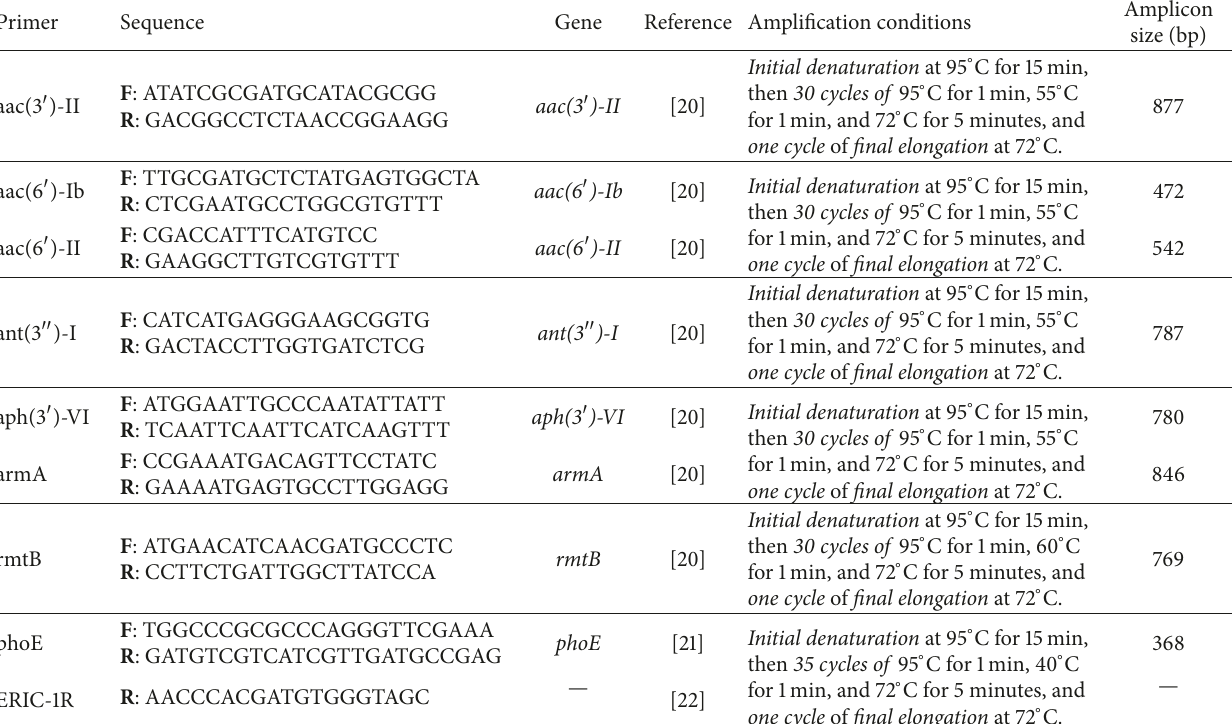
Table 1: Primer sets and PCR cycling conditions used for genotyping and amplification of genes encoding AMES. Primer Sequence